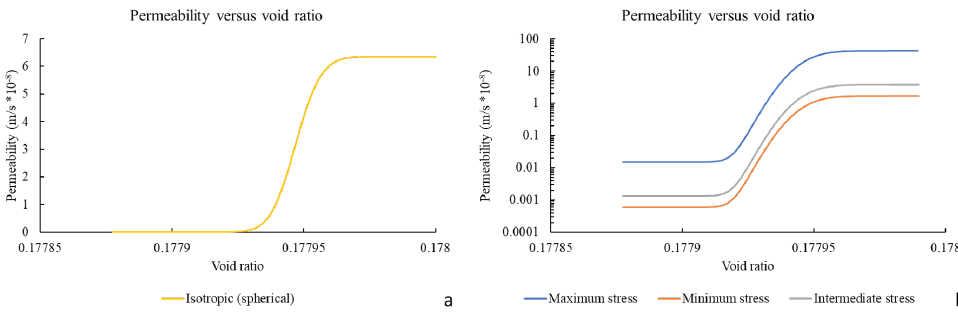
Figure 6. The best matching void ratio dependent permeability relation for normalised and isotropic microseismic cloud ( a ). The denormalised void ratio dependent permeabilities along maximum, minimum, and intermediate in-situ stress directions for stage 12 hydraulic fracturing ( b ).